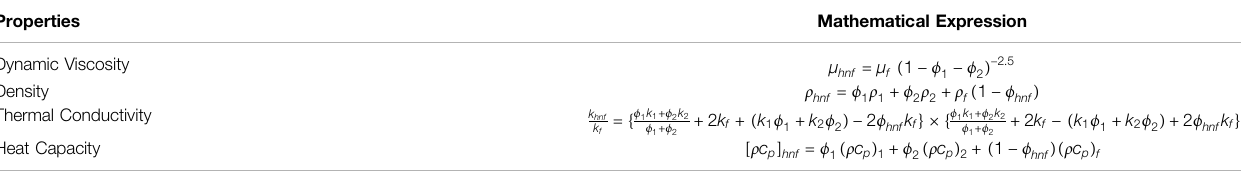
TABLE 1 | Mathematical expression of various thermophysical quantities. Properties Mathematical Expression